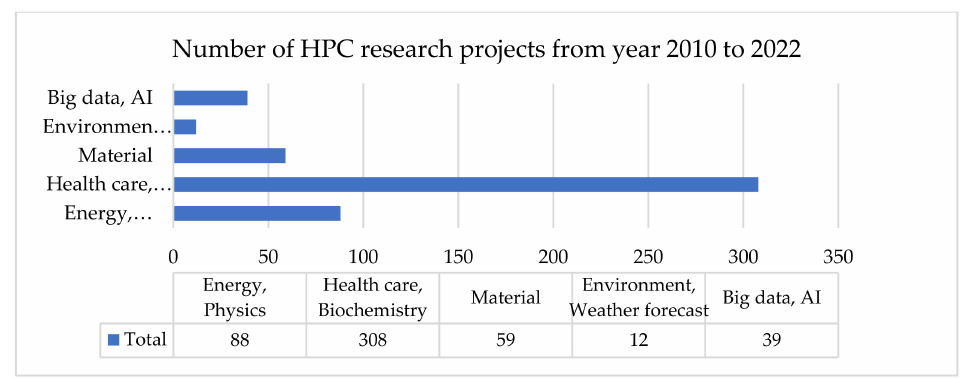
Figure 1. Statistics of Job Submission to e-Science Service Grouped by Research